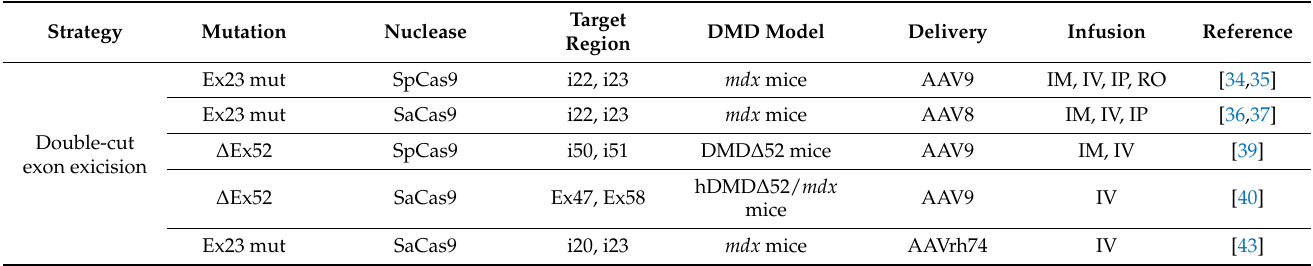
Table 1. CRISPR-mediated therapeutic strategies in preclinical DMD